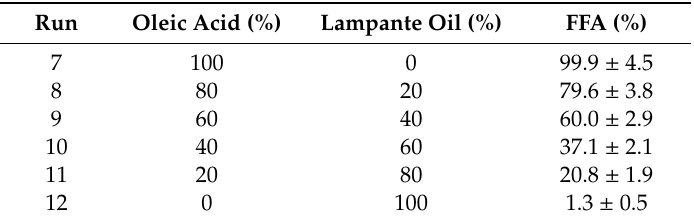
Table 2. Esterifications of mixtures of commercial oleic acid and lampante olive oil over SnCl 2 · 2H 2 O at 160 ◦ C for 60 min (mean ± SD, n = 2). Run Oleic Acid (%) Lampante Oil